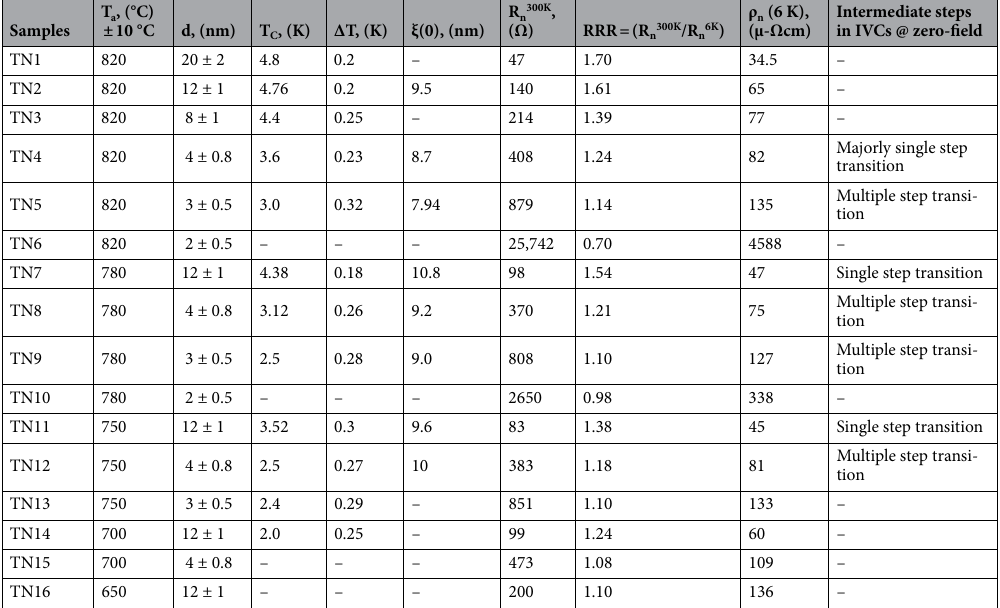
Table 1. Superconducting parameters obtained for TiN thin films fabricated by using the substrate mediated nitridation